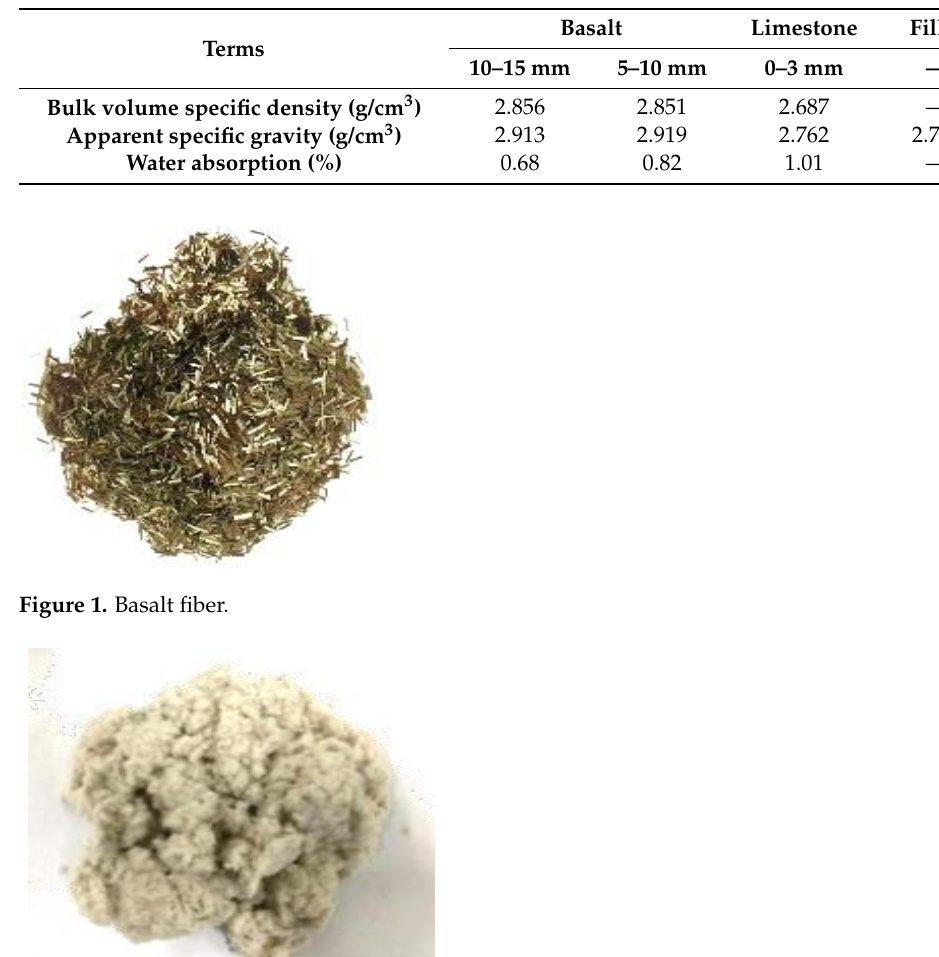
Table 2. Specific density of aggregates.